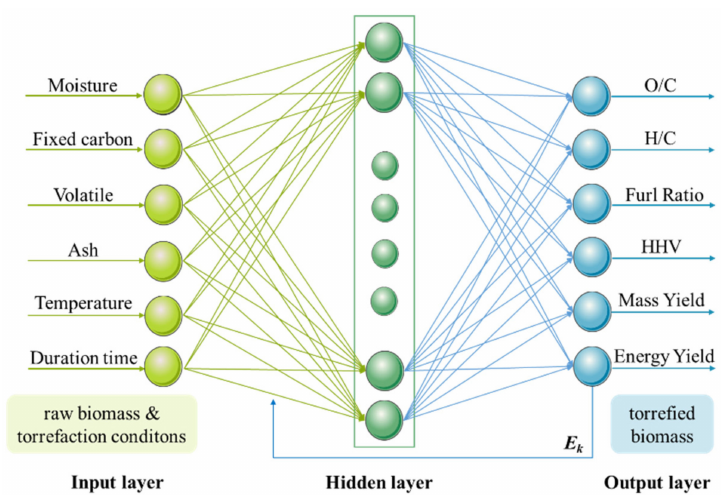
Figure 1. BPNN model for prediction of fuel properties of torrefied